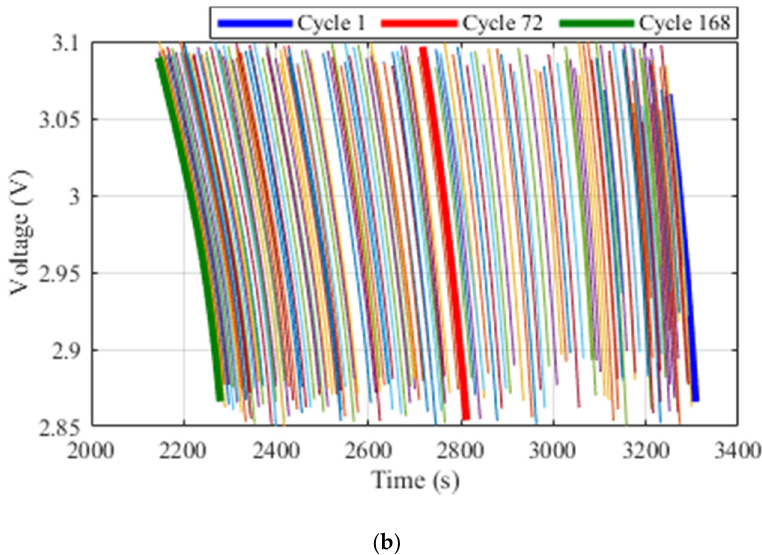
Figure 2. Discharging terminal voltage profiles at different battery cycles: ( a ) Voltage Region 3.75–3.5 V; ( b ) Voltage Region 3.1–2.85 V.